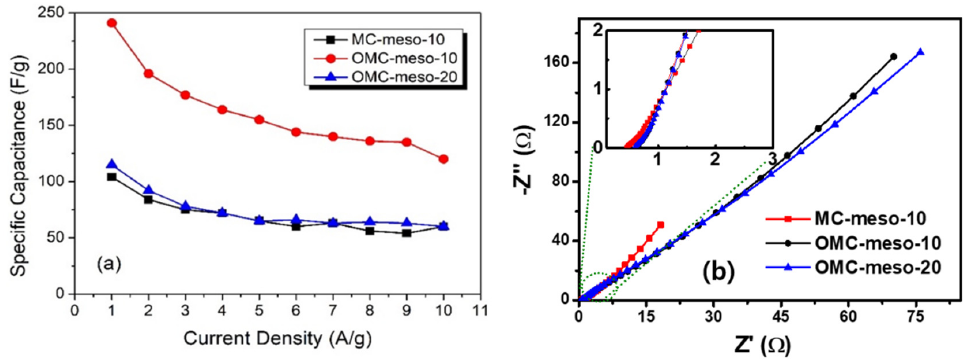
Figure 8. Specific capacitances at different current densities ( a ) and Nyquist plots ( b ) of MCs and OMCs prepared with different amounts of mesophase